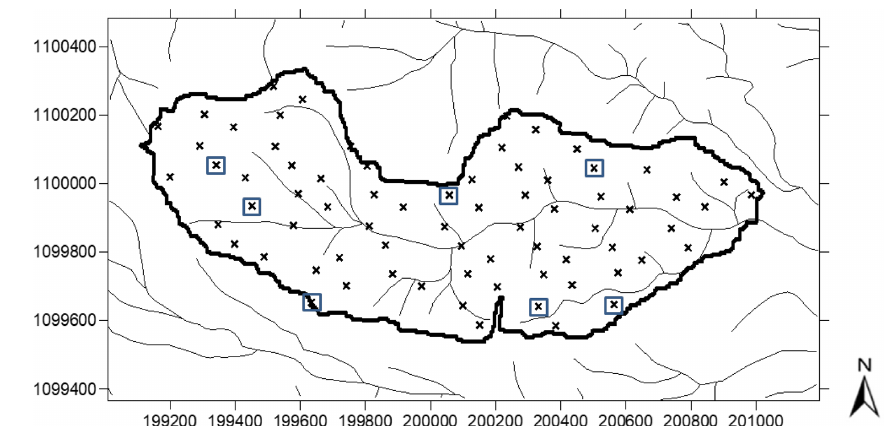
Figure 1. Map of the study site: a 1km 2 micro-watershed. “X” symbols mark the 69 sampling locations. The seven squares show where pits were dug down to a depth of 2m for bulk-density measurements. Thin lines indicate permanent stream channels. Numbers along the axes are UTM coordinates. See Gómez-Delgado et al. (2011) for more geographical details.